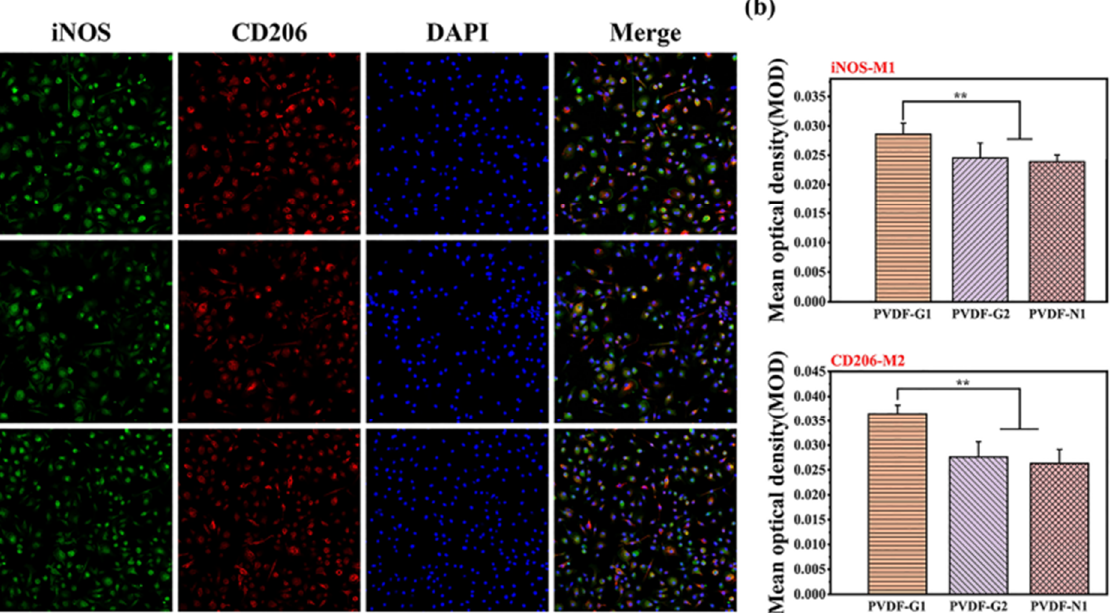
Figure 5. Immunofluorescence images ( a ) and semi-quantitative statistics ( b ) of the macrophage surface markers CD206 (M2 marker, red) and iNOS (M1 marker, green) (**p < 0.01).